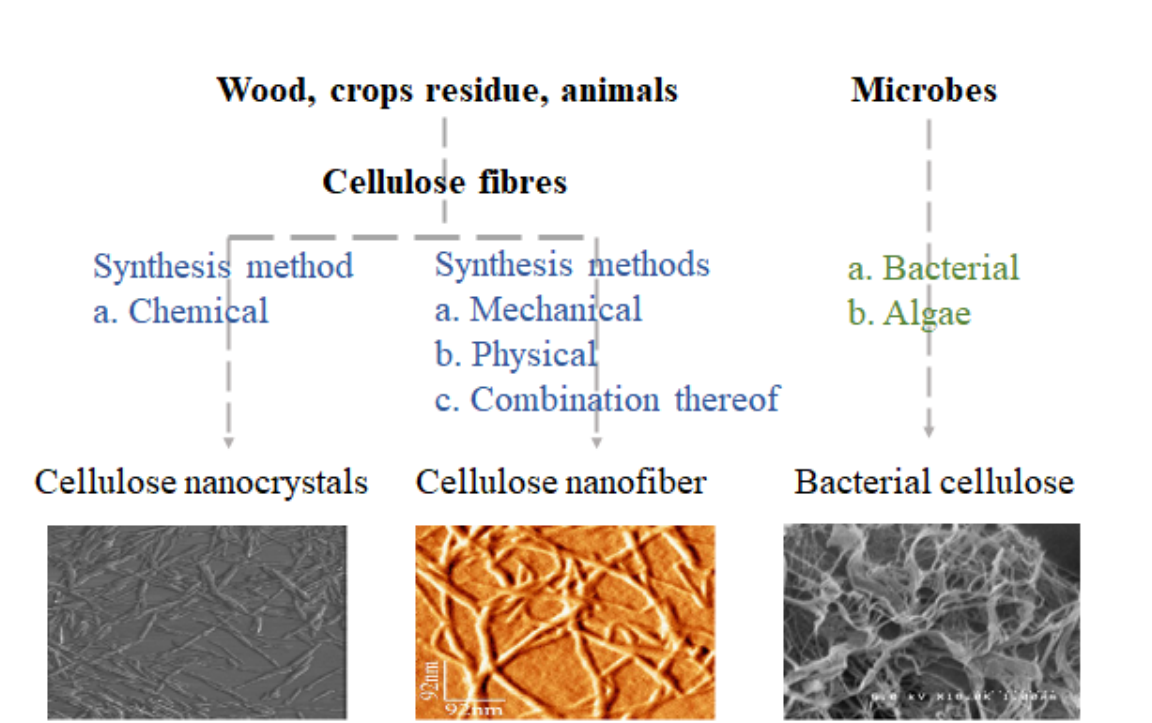
Figure 4. Morphology of cellulose nanocrystals, cellulose nanofibers and bacterial nanocellulose. Adapted from ref. [14].